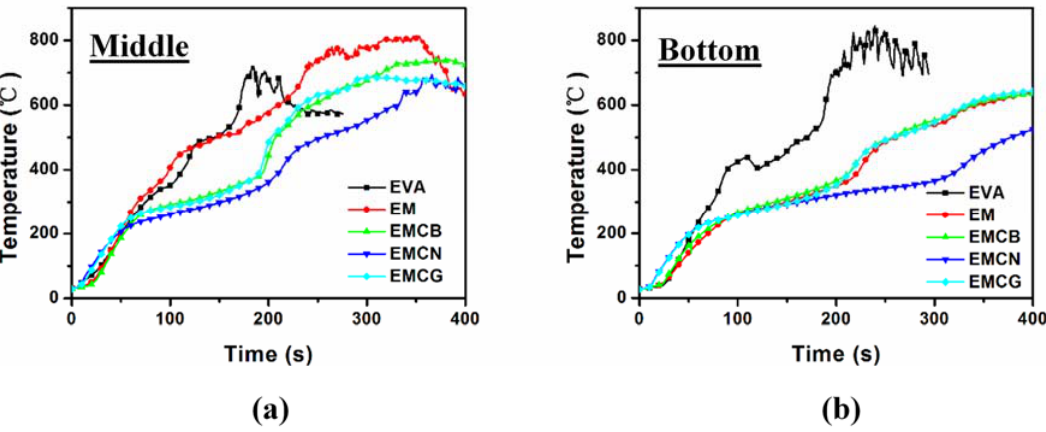
Figure 6. Temperature of specimens versus time for pure EVA and its nanocomposites: ( a ) middle temperature of specimen, and ( b ) bottom temperature of specimen.